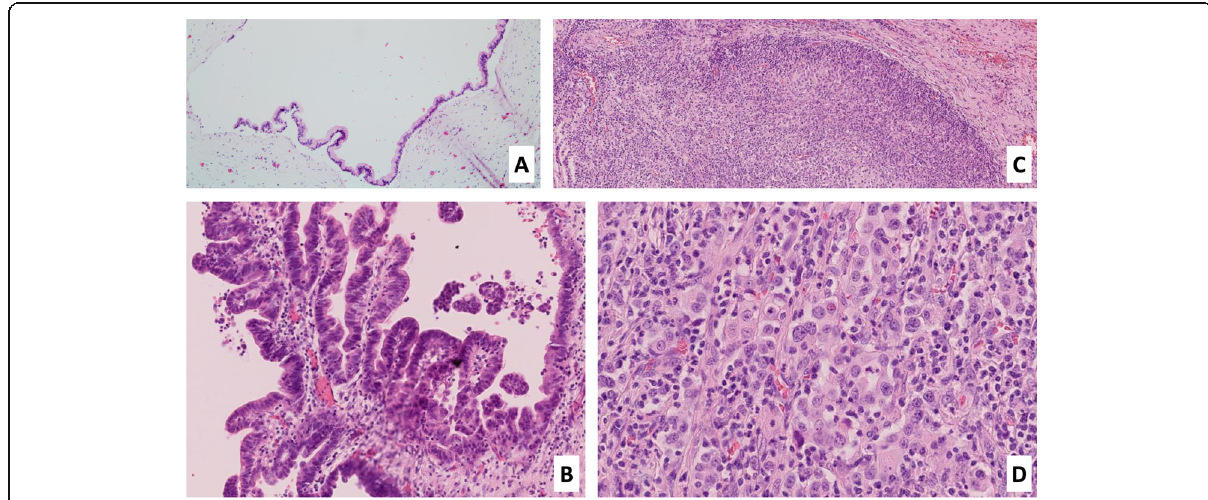
Fig. 3 Microscopic examination of the Intraductal Pancreatic Mucinous Neoplasm (IPMN) and the Pancreatic Medullary Carcinoma (PMC). A : Gastric-type IPMN in low grade dysplasia (HE x5). B : Pancreatobiliary-type IPMN in high-grade dysplasia (HE x10). C : The pushing borders appearance of the PMC (HE x5). D : Sheets of poorly differentiated epithelial cells of the PMC, with a large nucleus and visible nucleoli; accompanied by a diffuse inflammatory infiltrate (HE x20)